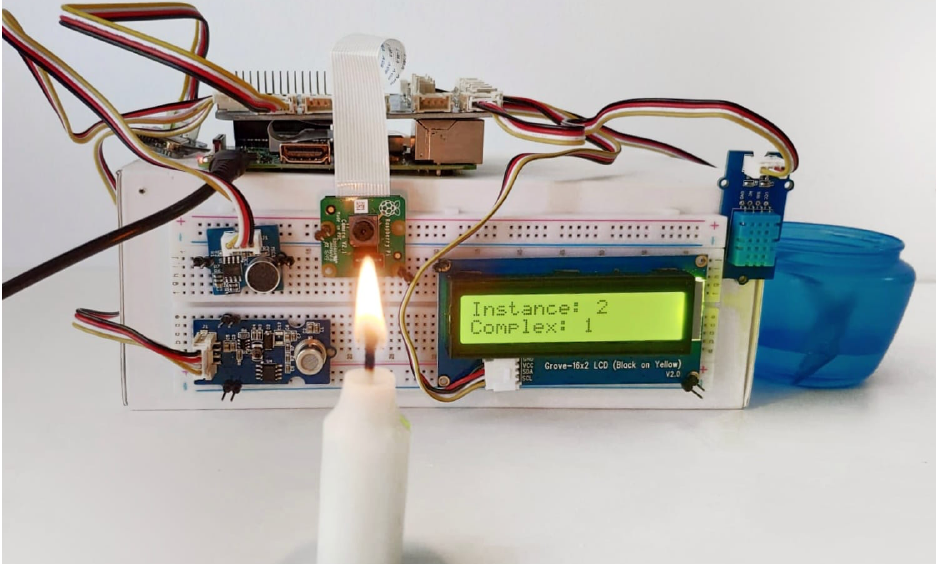
Figure 7. The experimental EDU when detecting 2 instance events (noise and water) and 1 complex event